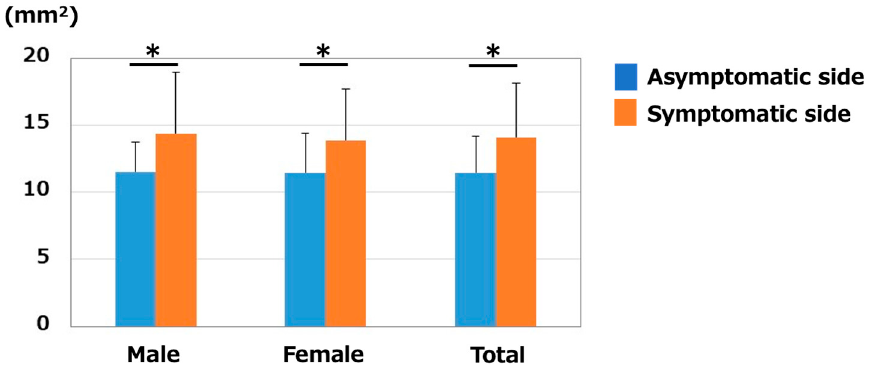
Figure 2. Median nerve CSA (mm 2 ). CSA was significantly larger on the symptomatic side in both males and females. * p < 0.05 between the sides.